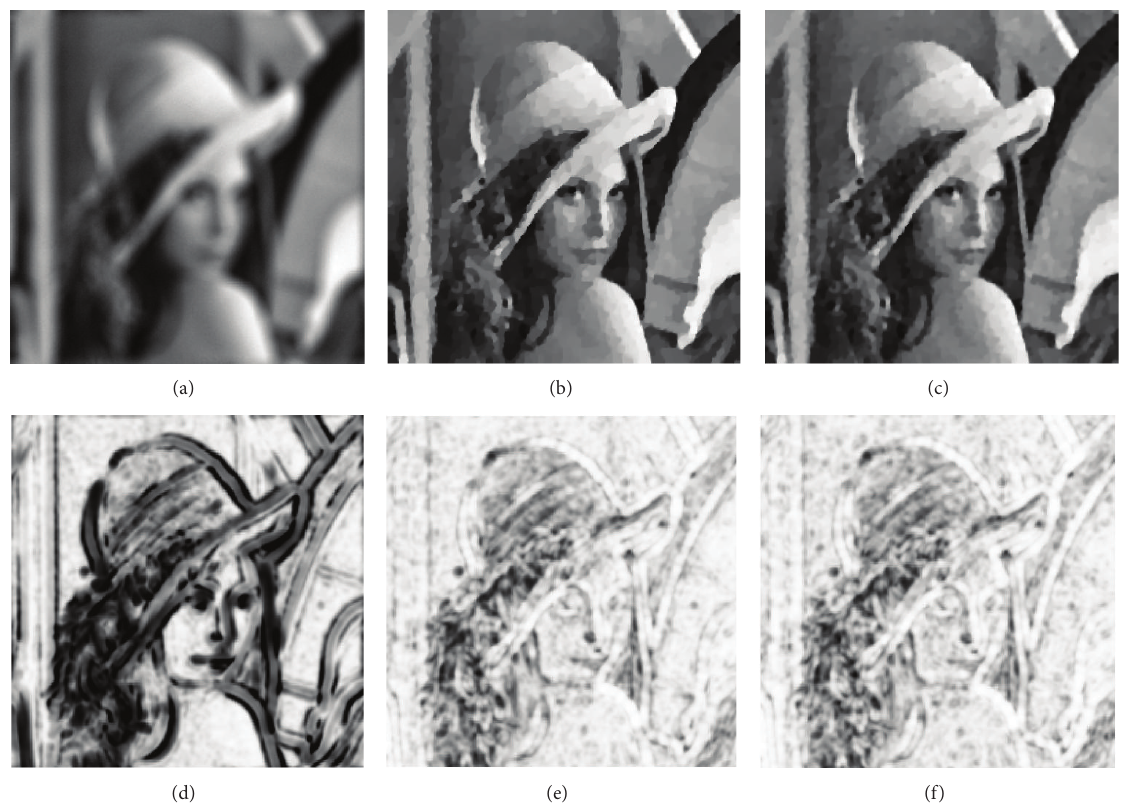
Figure 5: Results of different methods when restoring blurred and noisy image “Lena” degraded by out-of-focus blur with radius 3 and a noise with BSNR = 30 dB: (a) blurred and noisy image “Lena”; (b) restored image by FastTV; (c) restored image by FNDTV; (d) SSIM index map of the corrupted image; (e) SSIM index map of the recovered image by FastTV; (f) SSIM index map of the recovered image by